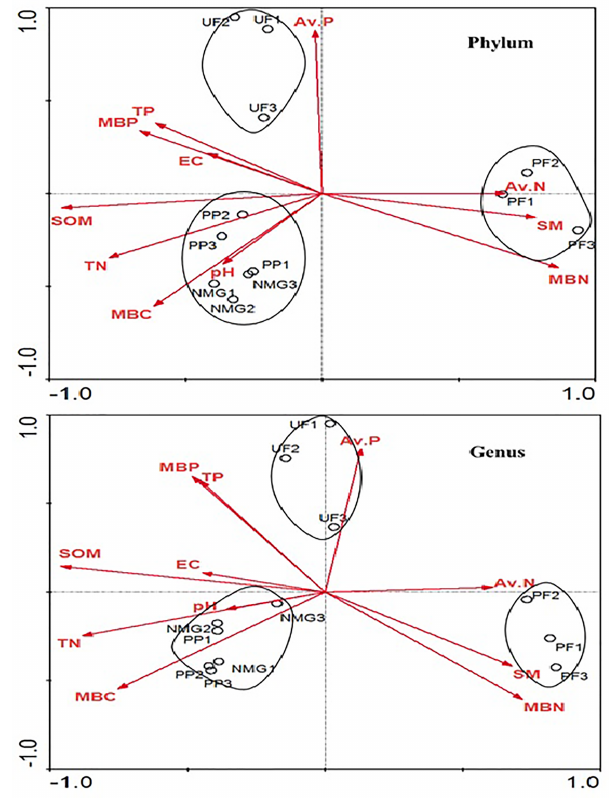
Figure 5. Canonical correspondence analysis (CCA) of soil bac- terial community structures and environmental parameters. Arrows indicate the direction and magnitude of environmental parameters associated with bacterial community structures. Abbreviations: Av. P: available P; SOM: soil organic matter; TP: total P; TN: total N; EC: electrical conductivity; MBC: microbial biomass C; MBN: microbial biomss N; MBP: microbial biomass P; NMG: native meadow grassland; UF: 50-year upland field; PF: 26-year paddy field; PP: 34-year poplar